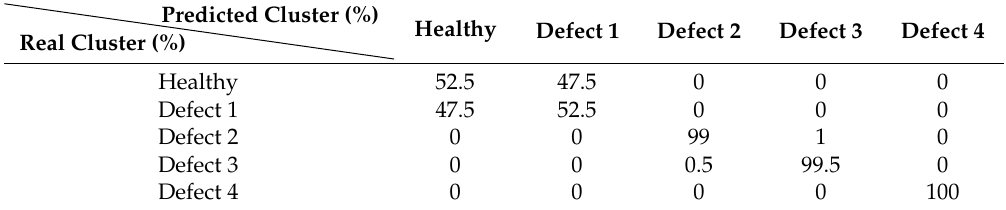
Table 1. Matching matrix of the clustering results plotted in Figure 12b.